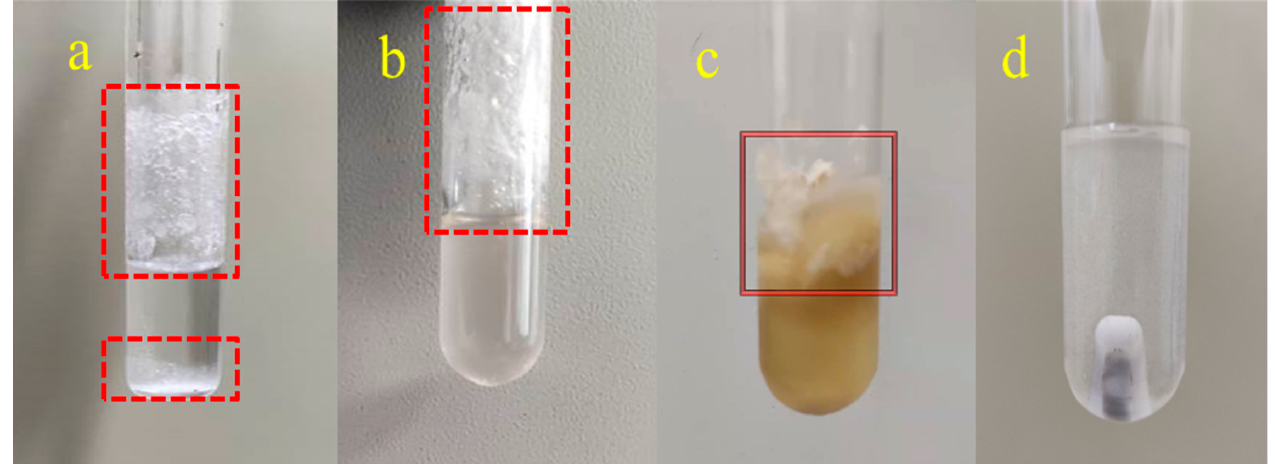
Figure 4. Phase separation of SAT ( a ) after five cooling and heating cycles, ( b ) adding 2.5 wt.% CMC, ( c ) standing at a constant temperature of 70 °C for 24 h and ( d ) stirring for 48 h.